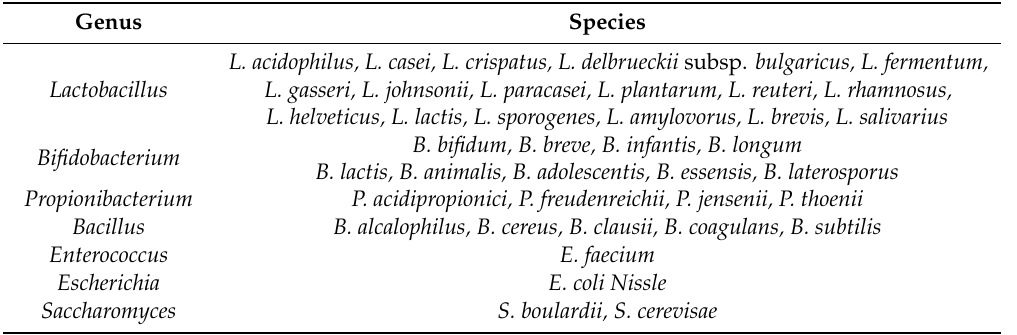
Table 4. Commonly used probiotic